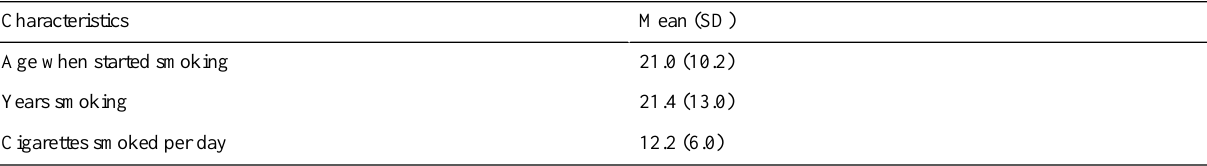
Table 1. Baseline characteristics of smoking history and experience (n=41).